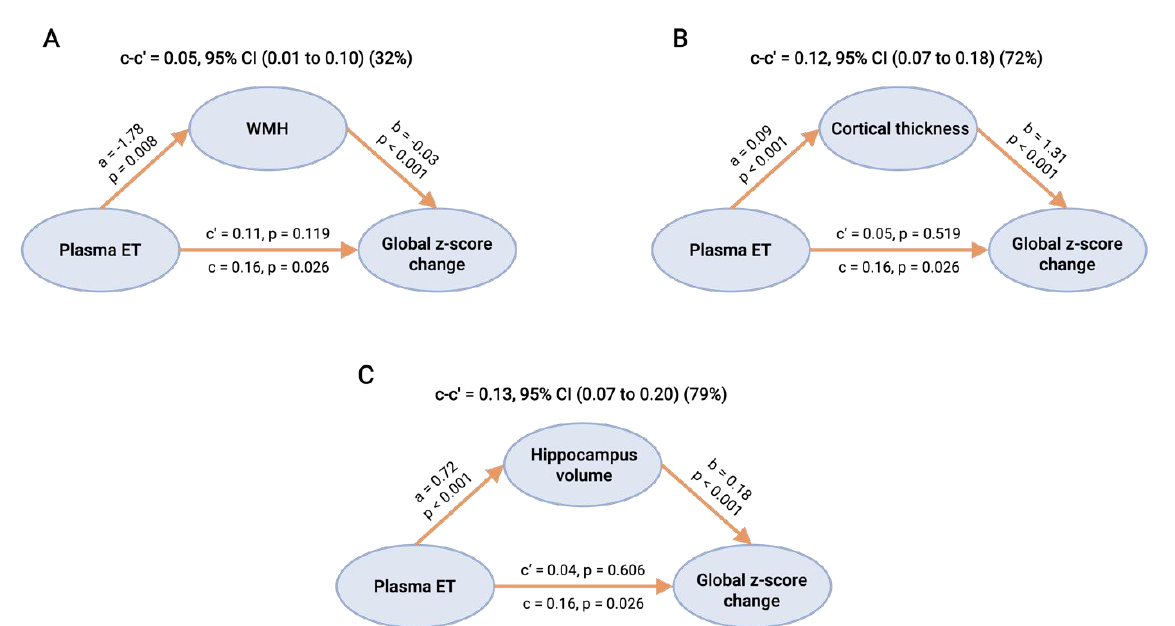
Figure 3. Mediation effects of brain MRI markers in the associations of baseline plasma ET levels with global cognitive decline. Causal mediation analyses of the total mediating effects (95% CI) of WMH ( A ), global cortical thickness ( B ), and hippocampus volume ( C ) are reported when there was a statistically significant mediation, as estimated by the difference between the total (path c) and direct (path c’) effect of plasma ET on cognitive change (c-c′). The direct effect of plasma ET on cognition (c’) was estimated by adjusting the association between plasma ET and cognitive change (total effect, c) for the mediator. The direct effect of plasma ET on the imaging markers is designated path a, while the direct effect of these markers on cognition is path b. All paths were adjusted by age, gender, education, APOE ε4 status, hypertension, diabetes, cardiovascular disease, and total intracranial volume. Abbreviations: CI = confidence interval, ET = ergothioneine, WMH = white matter hyperintensities.